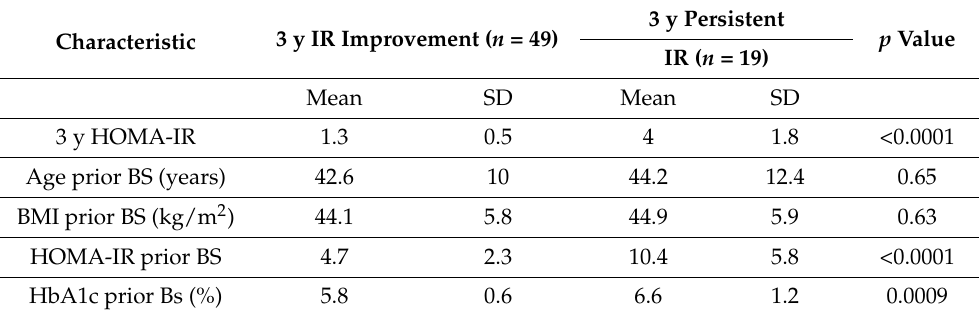
Table 5. Characteristics of patients with (or without) IR improvement at 3 years